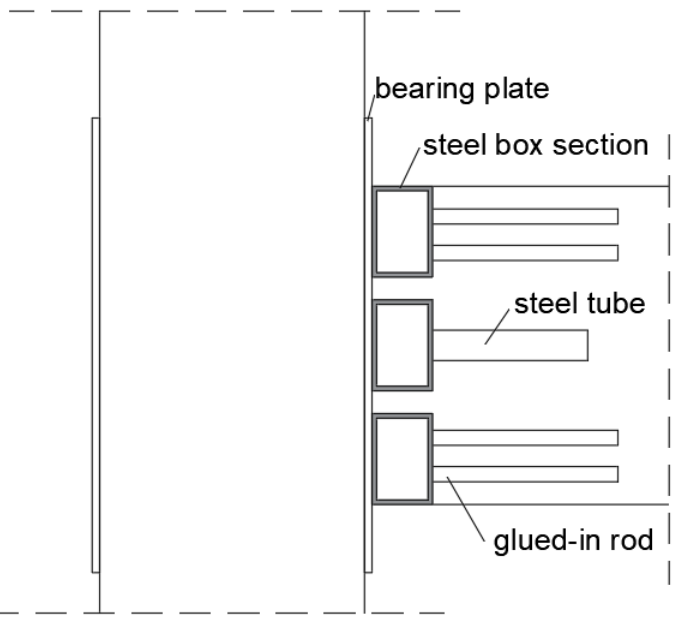
Figure 21. Joint geometry and steel components studied by [55]. (adapted from Ref.